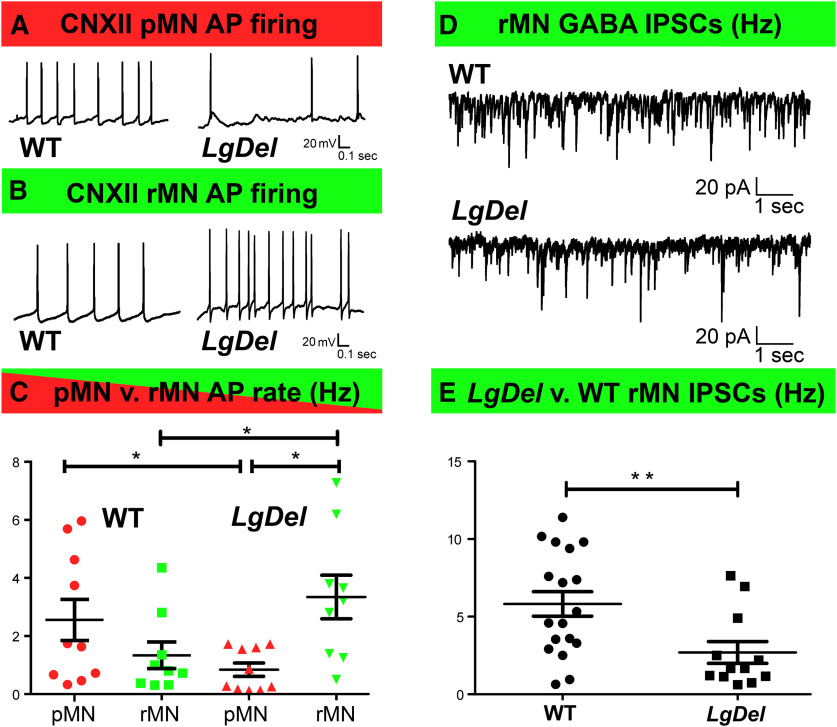
Differences in LgDel protruder and retractor MN spontaneous activity. A, Representative traces of spontaneous AP activity of protruder CNXII MNs (pMNs, red) from neonatal WT (left) and LgDel (right) pups. B, Spontaneous AP activity of retractor CNXII MNs (rMNs, green) from neonatal WT (left) and LgDel (right) pups. C, AP frequency was significantly higher in LgDel rMNs compared with both LgDel pMNs and WT rMNs as shown in C (LgDel rMN (3.34 ± 0.7 Hz, n = 10) compared with LgDel pMN (0.84 ± 0.2 Hz, n = 9, p = 0.011 unpaired Student’s t test and WT rMN (1.34 ± 0.4 Hz, n = 9, p = 0.0398 unpaired Student’s t test). The pMN AP firing was statistically higher from WT (2.56 ± 0.7 Hz, n = 10) than LgDel (0.84 ± 0.2 Hz, n = 10, p = 0.0434, unpaired Student’s t test). D, Typical GABAergic IPSCs events in WT (top) and LgDel (bottom) neonatal rMNs. E, Scatter plots show IPSC frequency was significantly greater in WT (5.82 ± 0.8 Hz) versus LgDel rMNs (2.70 ± 0.7 Hz, unpaired Students’ t test, df = 28, p = 0.0099). For all graphs, data expressed as mean ± SEM; statistical comparisons are noted as *p < 0.05, **p < 0.01.